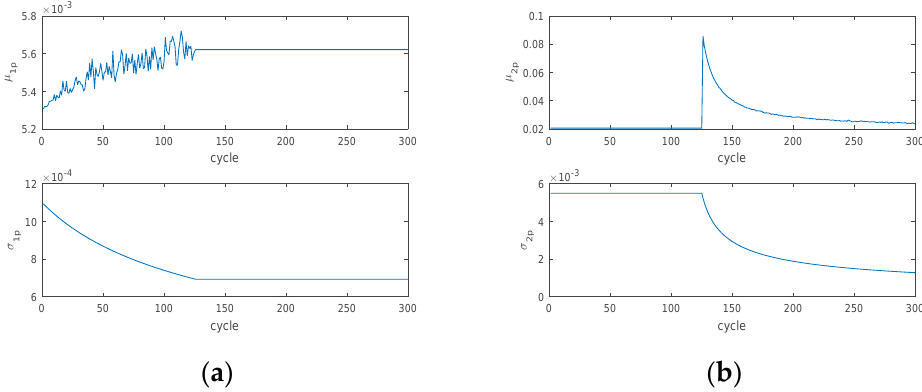
Figure 7. Online estimation of parameters. ( a ) Parameters in the first phase. ( b ) Parameters in the second phase.